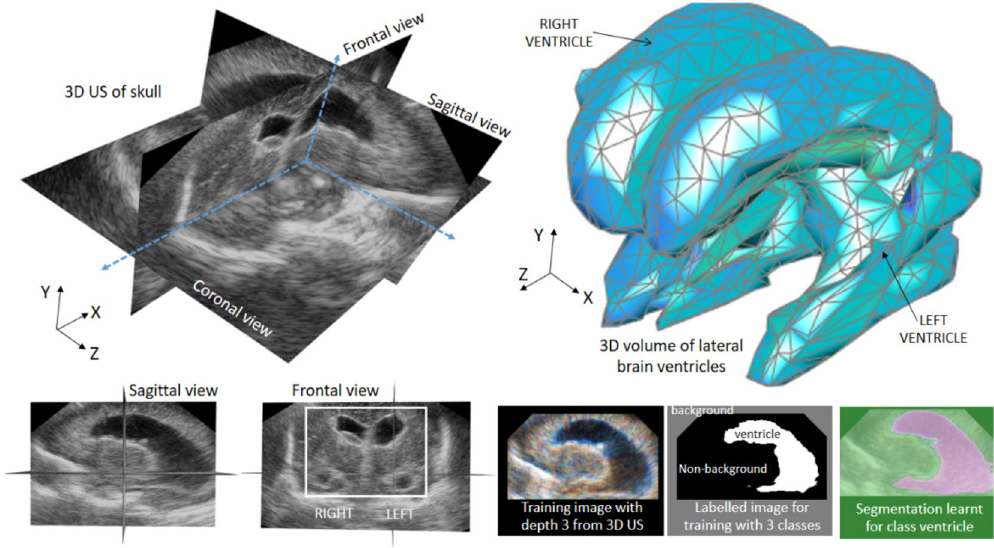
Figure 8. Left, orthoslice visualization of 3D US of the head of one infant with PHVD. The dilated ventricles are clearly visible. Top right, example of 3D patch surface visualization of the ventricles obtained using deep learning. Bottom left, representative sagittal and coronal slices of one 3D US of one patient with PHVD. Bottom right, representative RGB image generated by stacking three consecutive sagittal slices, the corresponding labels, and the segmentation calculated using a convolutional neural network